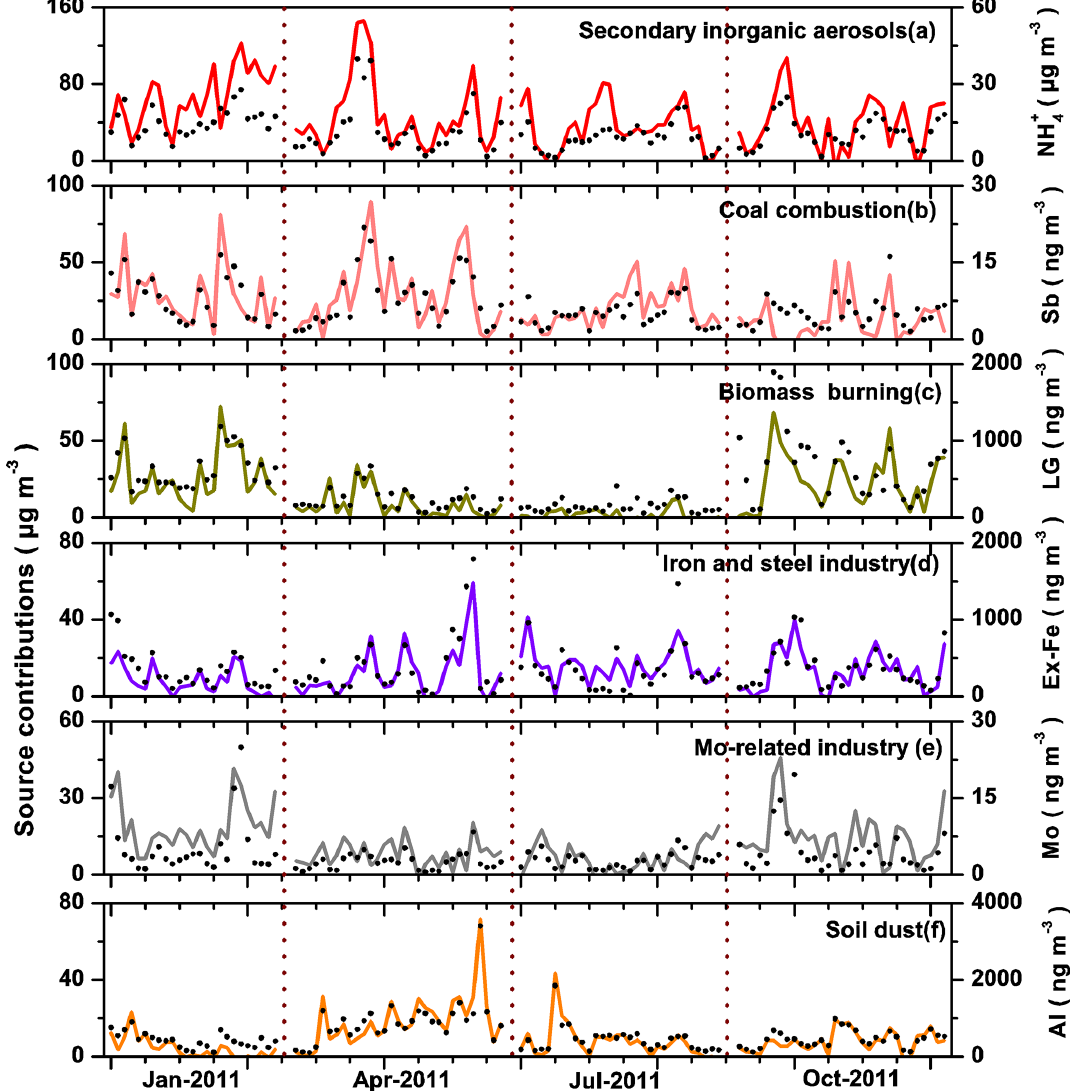
Figure 7. Time series of daily contributions from each identified source (continuous line) and specific chemical species (black dots) between January and October